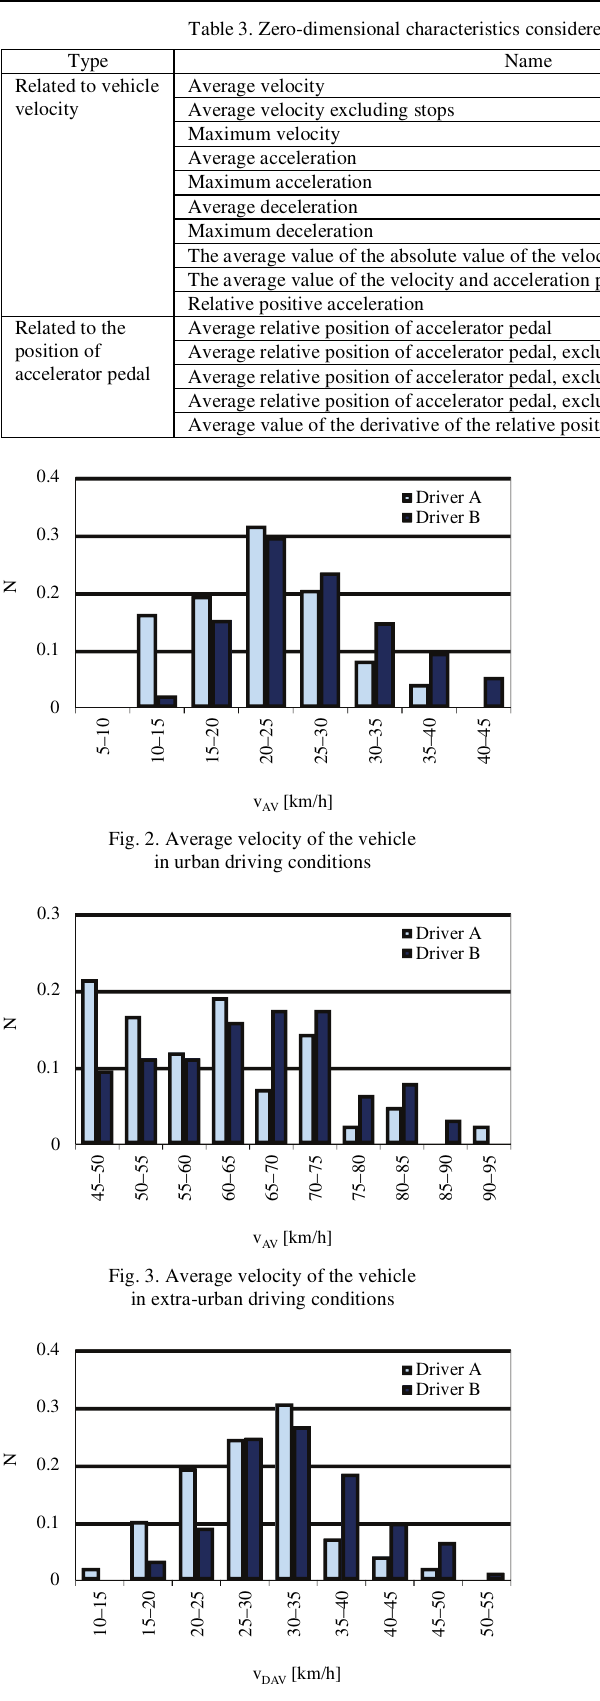
Fig. 4. Average velocity of the vehicle excluding stops in urban driving conditions